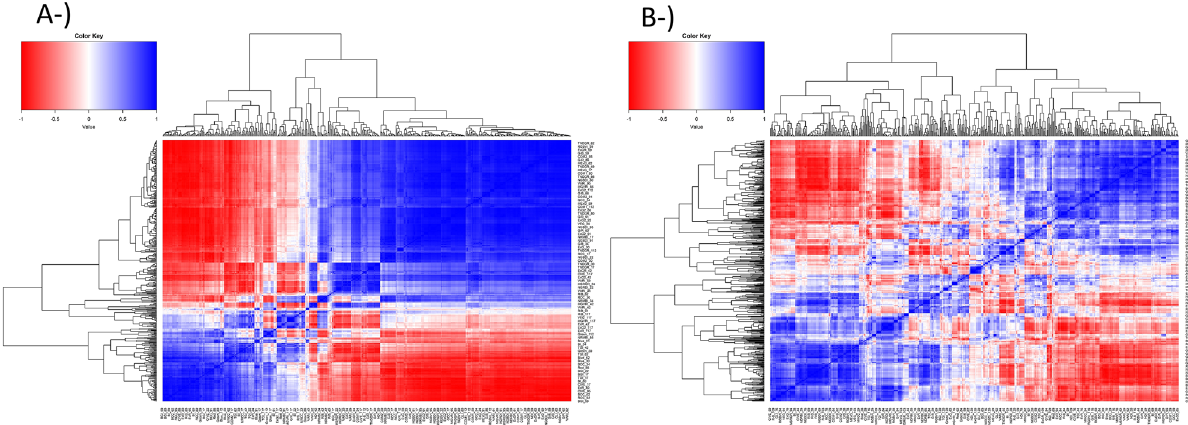
Figure 5. Pearson correlation coefficients for ( A ) 2020 and ( B ) 2021 phenomic data.